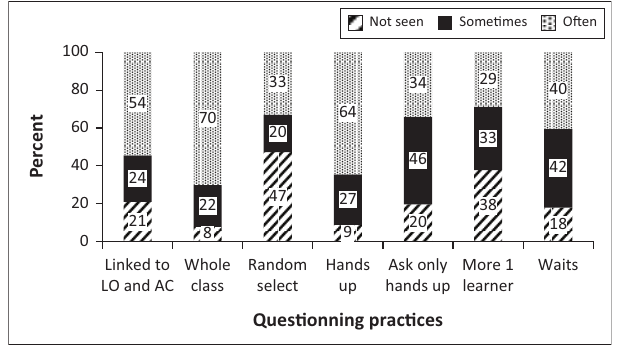
FIGURE 4: Teachers’ questioning practices observed during